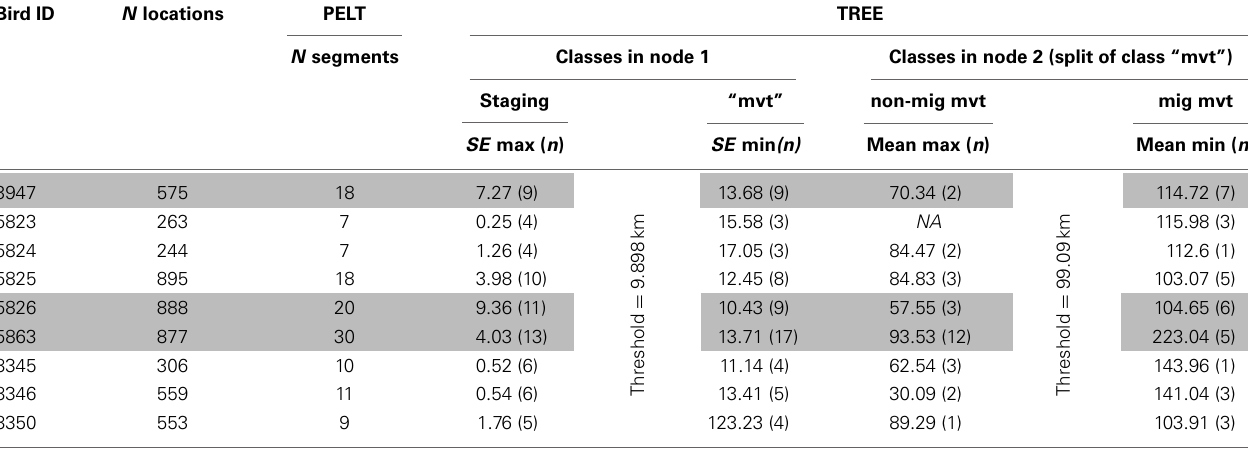
Table 1 | Results of the PELT-TREE method applied on movement histories of nine Macqueen’s Bustards. Bird ID N locations PELT TREE N segments Classes in node 1 Classes in node 2 (split of class “mvt”) Staging “mvt” non-mig mvt mig mvt